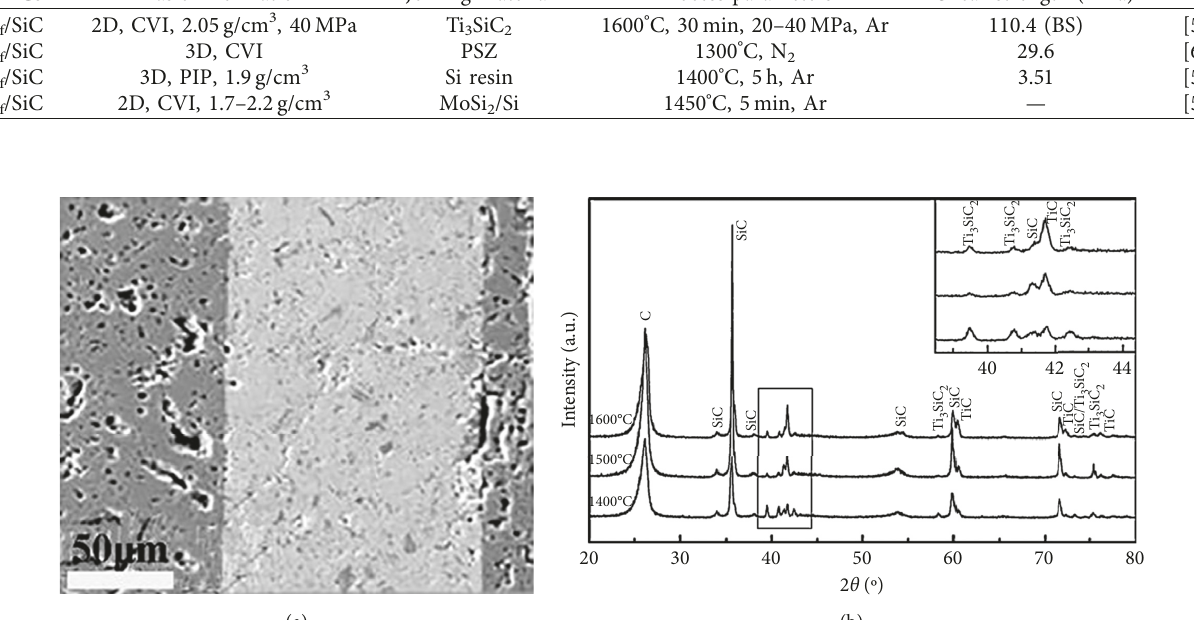
Figure 6: (a) The backscattered electron images and (b) XRD patterns of the fracture surfaces of the C